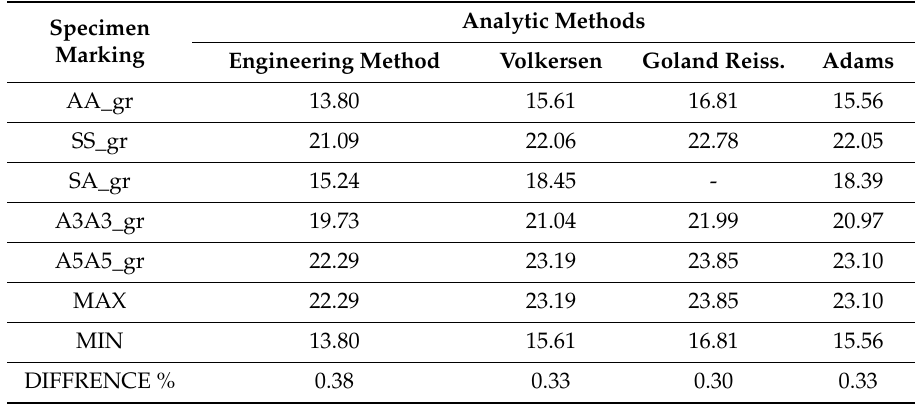
Table 7. Maximal shear stress values of adhesives on the basis of analytical methods.